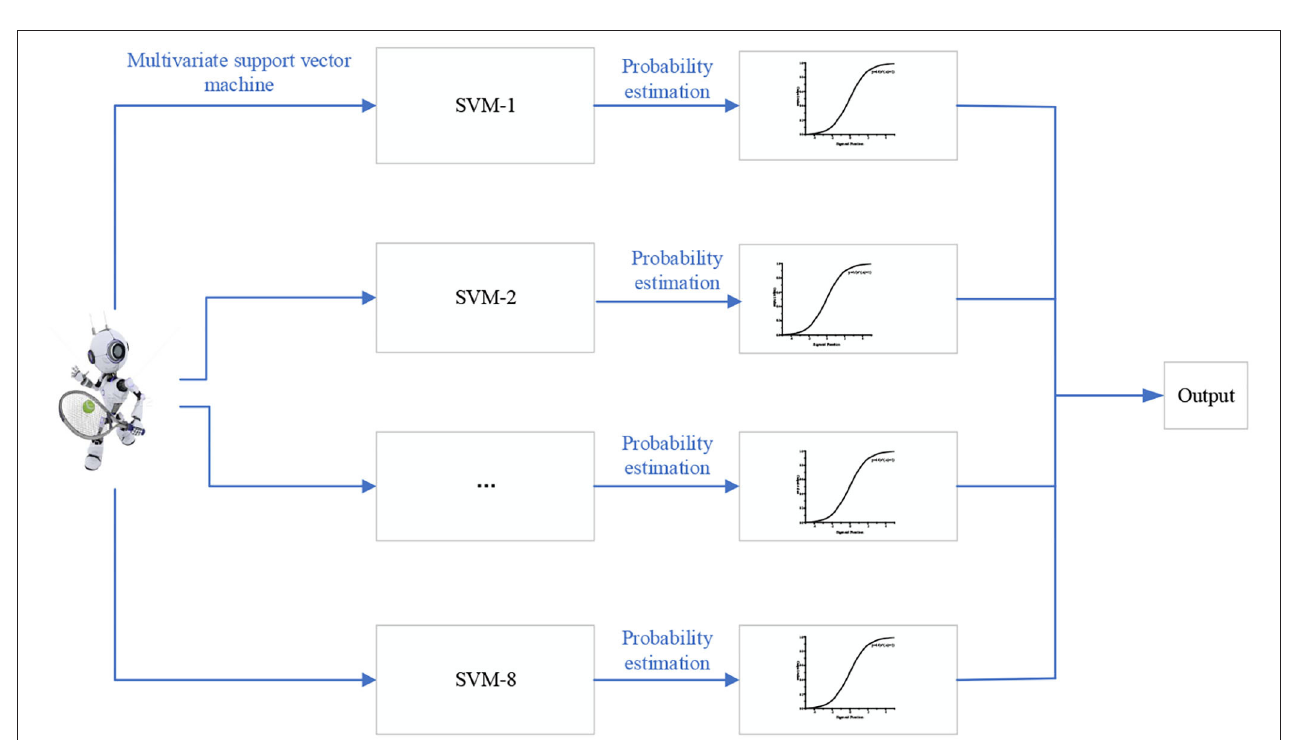
FIGURE 7 | Return strategy model of the tennis sports robot based on SVM.